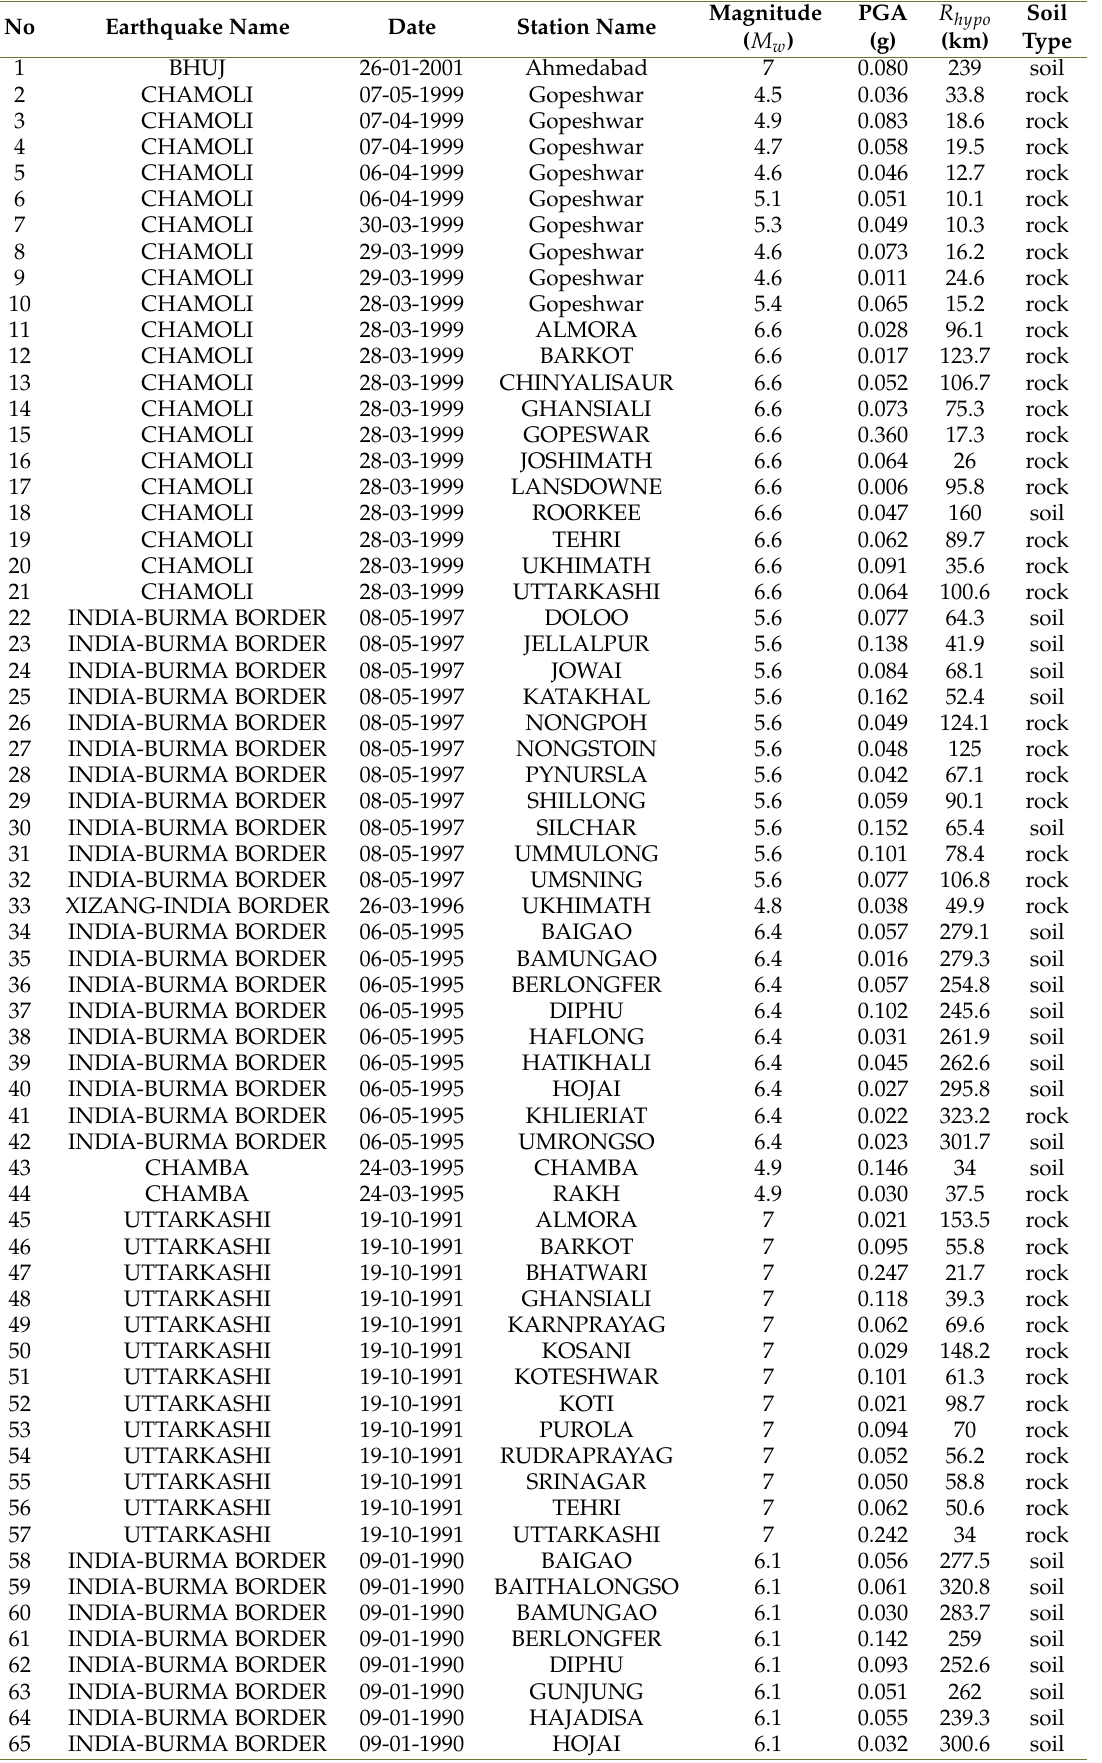
Table A1. Ground motions used in this